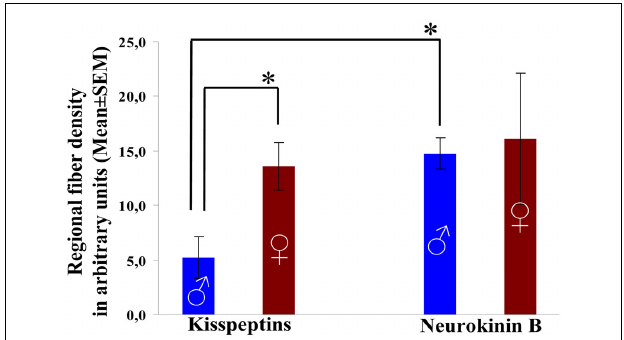
FIGURE 4 | Density of kisspeptin-IR and preproNKB-IR fibers in the Inf of aged men and women. The area covered by immunoreactive fibers (divided by the total area analyzed) was determined with the Image J software in digital photographs of the Inf and used as an index of regional fiber density (presented in arbitrary units). Areas of the photomicrographs that were occupied by labeled cell bodies and their proximal dendrites were erased using the Adobe Photoshop software and excluded from the analysis.The density of preproNKB-IR fibers defined this way was 2.8-fold as high as the density of kisspeptin-IR fibers in aged males, but not different in aged females.The density of kisspeptin-IR fibers showed a dramatic sexual dimorphism and was 2.5-fold higher in aged females vs. males.The mean density of preproNKB-IR fibers did not differ significantly between sexes. ∗ P <